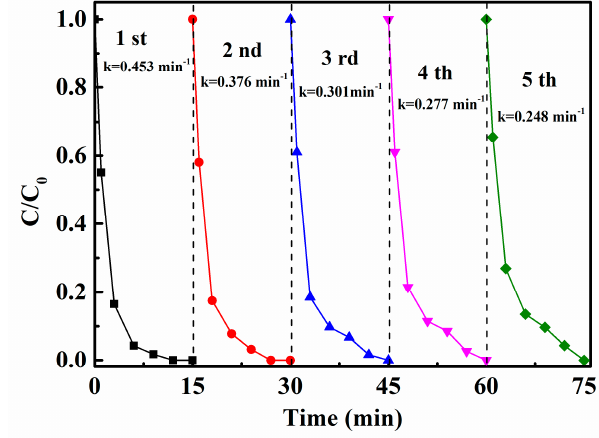
Figure 9. Circling runs for the DCF photodegradation in the presence of Ag 3 PO 4 /g ‐ C 3 N 4 (30%) under visible ‐ light irradiation. [DCF] = 1 mg L − 1 , [Ag 3 PO 4 /g ‐ C 3 N 4 (30%)] = 0.1 g L − 1 .